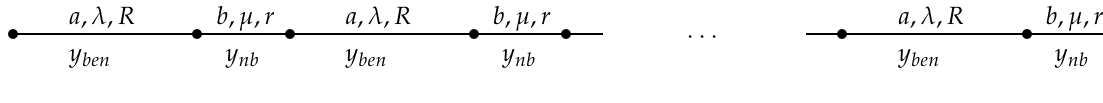
Figure 1. General scheme of periodic control